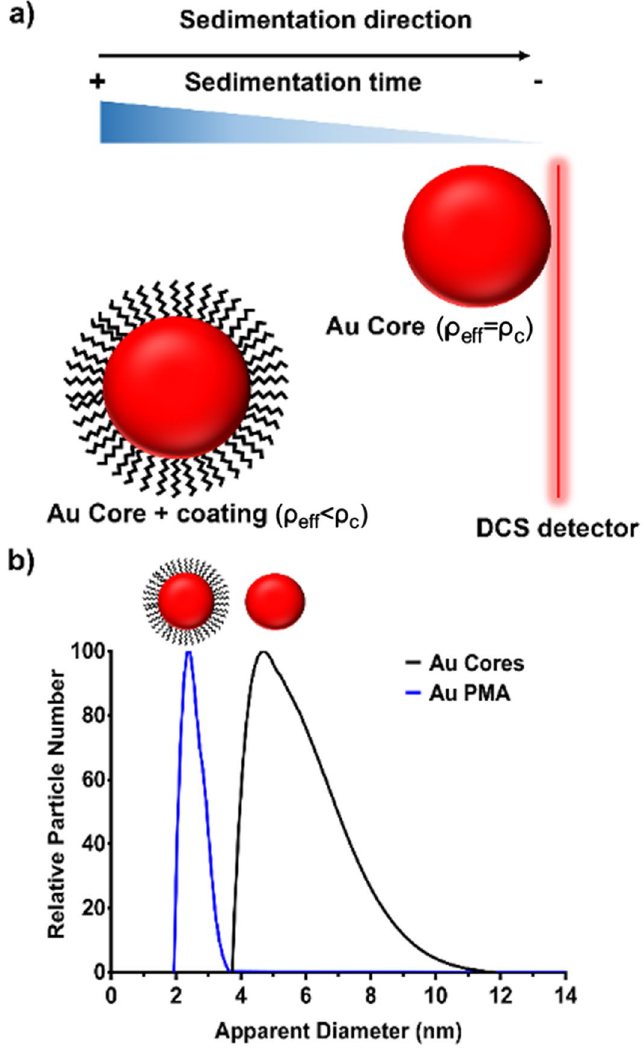
Scheme 2. Schematic representation of the DCS measurements of bare and coated AuNPs. As described in Eqs. (1)–(3), the NP sedimentation time under a centrifugal force is directly correlated to their effective density. In the case of a bare AuNP, the effective density ρ eff is close to the theoretical value (i.e. 19.3 g cm −3 ) while for a polymer coated AuNP, the effective density is affected (as described in the Eq. (3)) and also the sedimentation time. Scheme drawn with Adobe